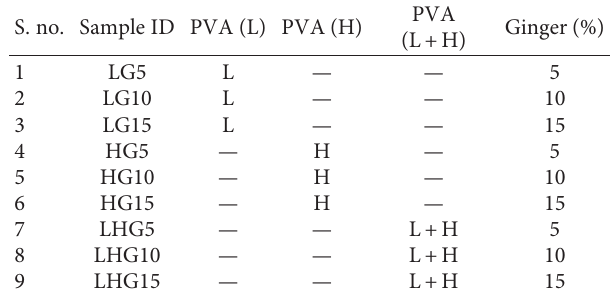
Table 3: Composition of ginger-based PVA films. Table 1: Composition of curcumin-based PVA films.